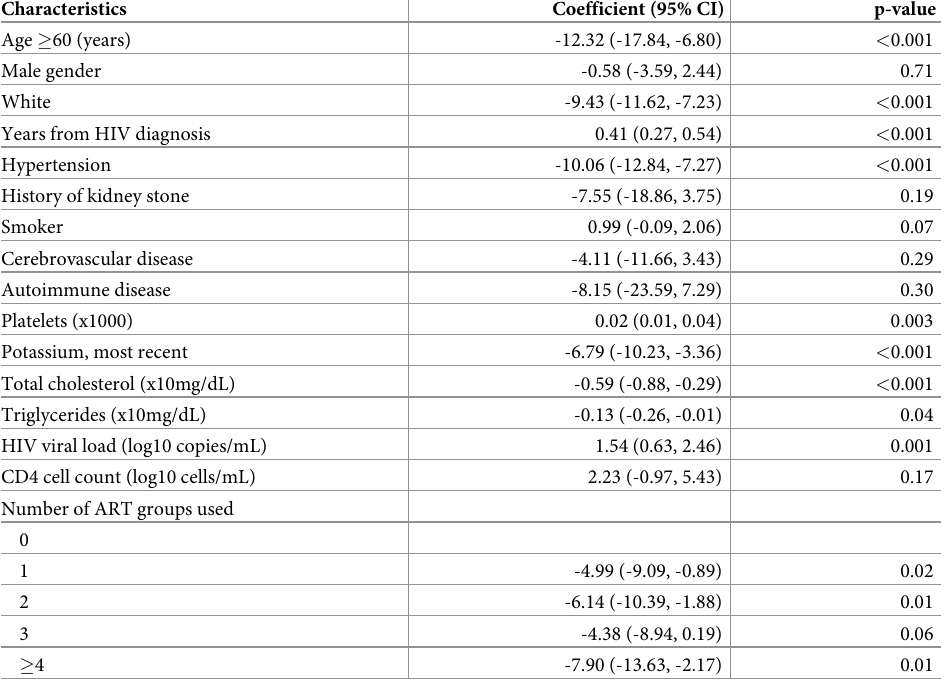
Table 3. Linear mixed model—Characteristics associated with the change in eGFR over the entire course of fol- low-up.